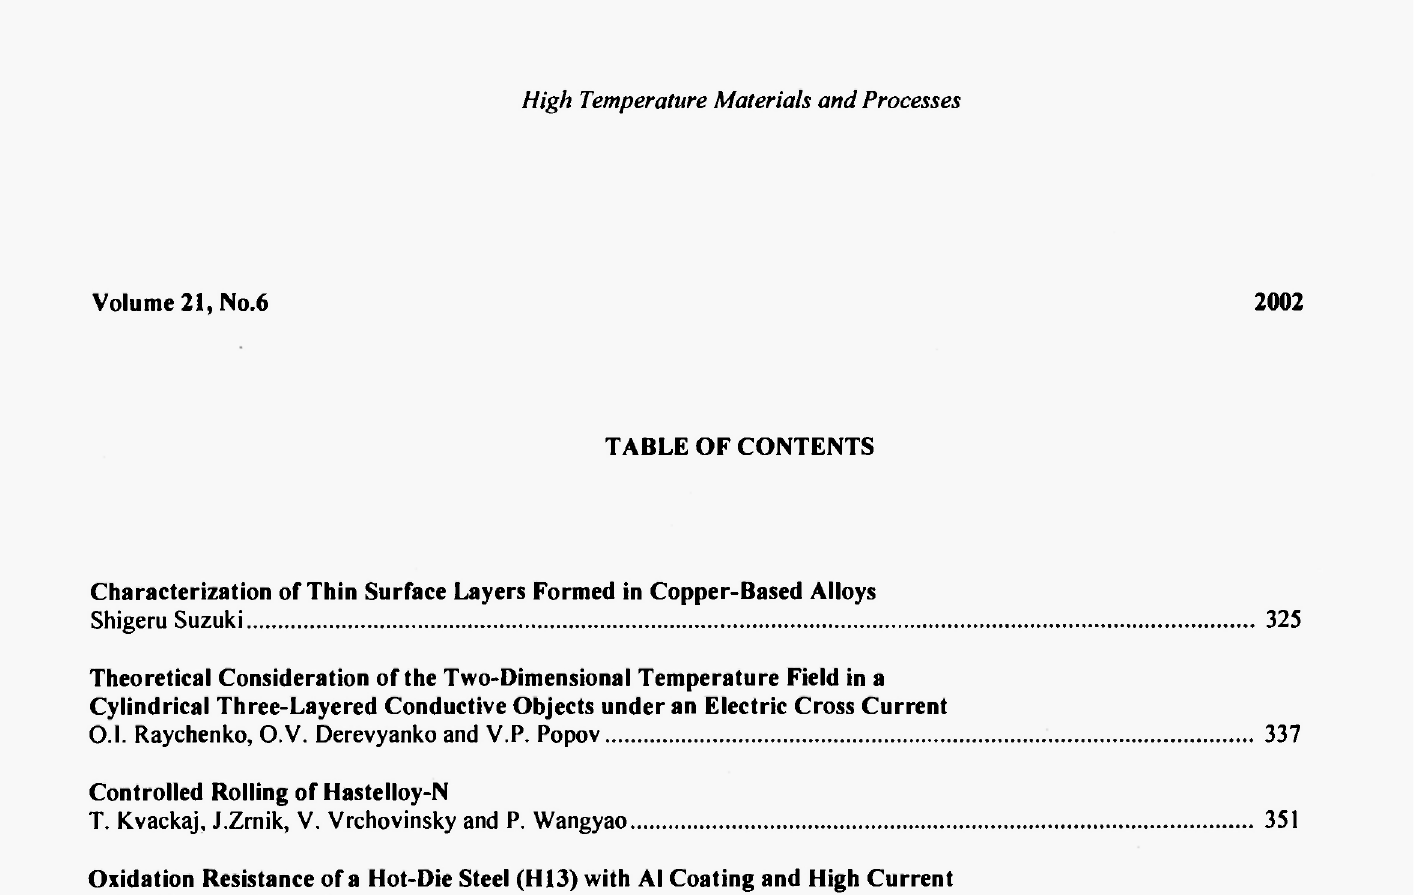
Characterization of Thin Surface Layers Formed in Copper-Based Alloys Shigeru Suzuki